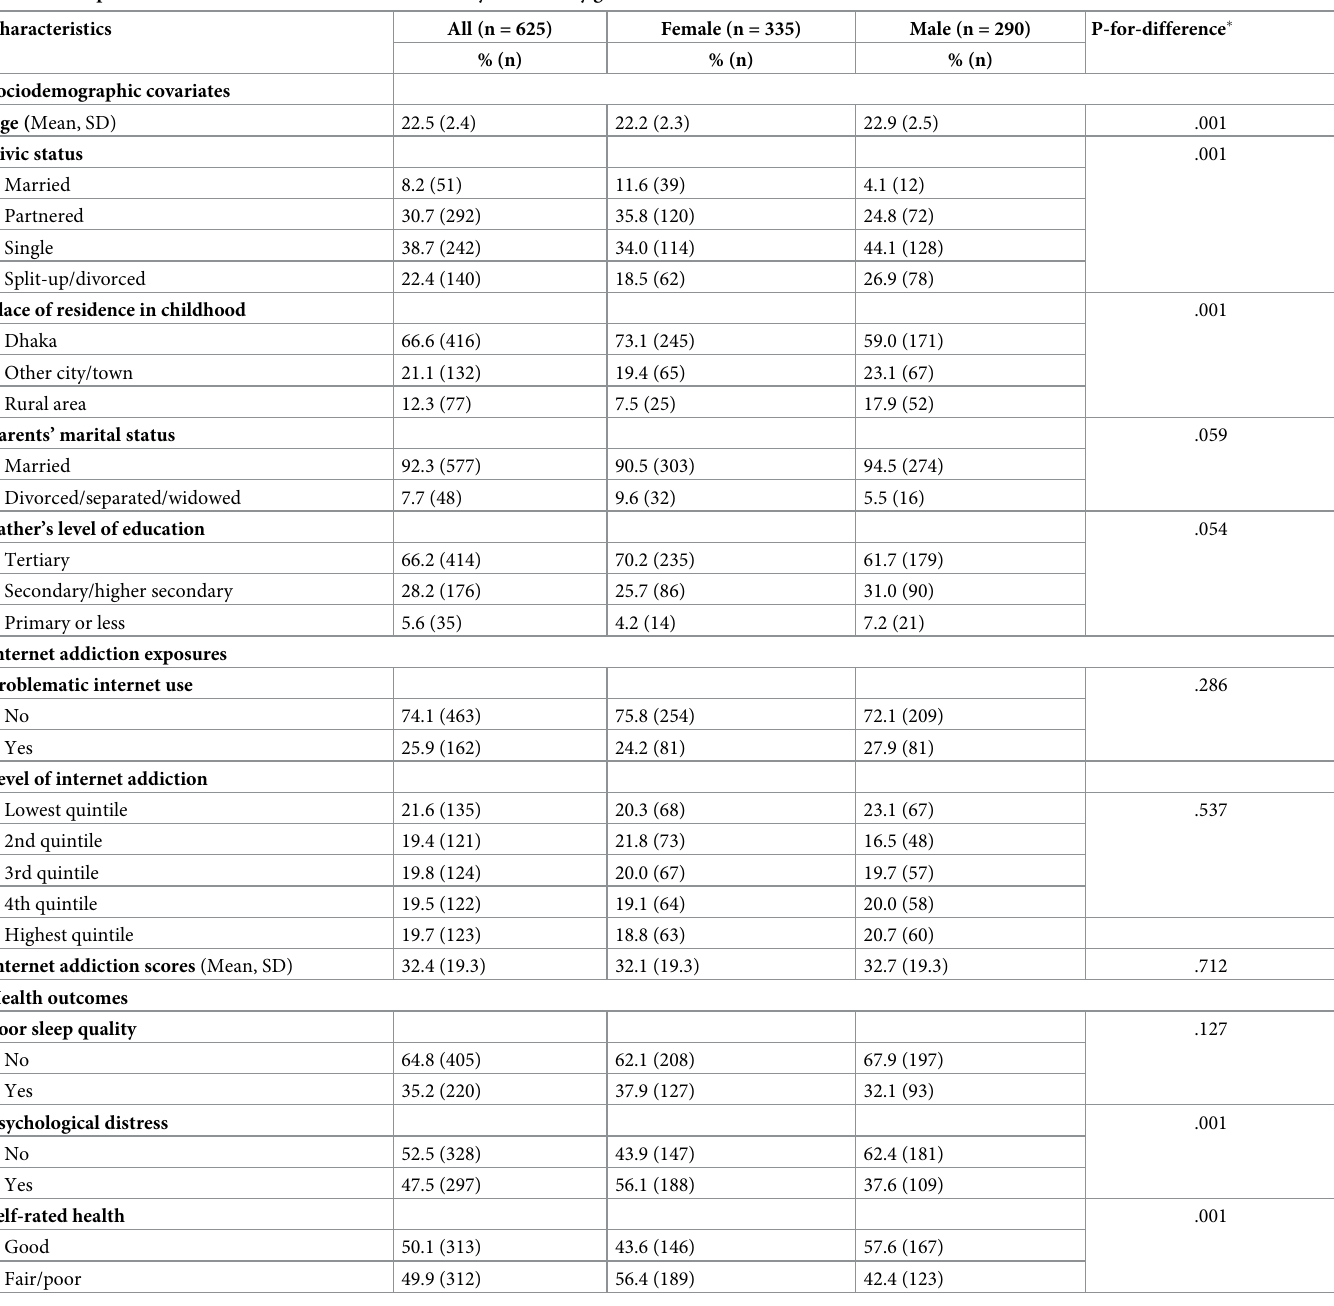
Table 1. Sample characteristics and the distribution of study variables by